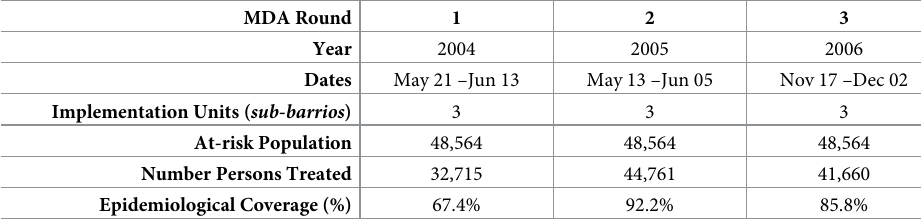
Table 3. Mass drug administration (MDA) for lymphatic filariasis in La Cie´naga focus, Dominican